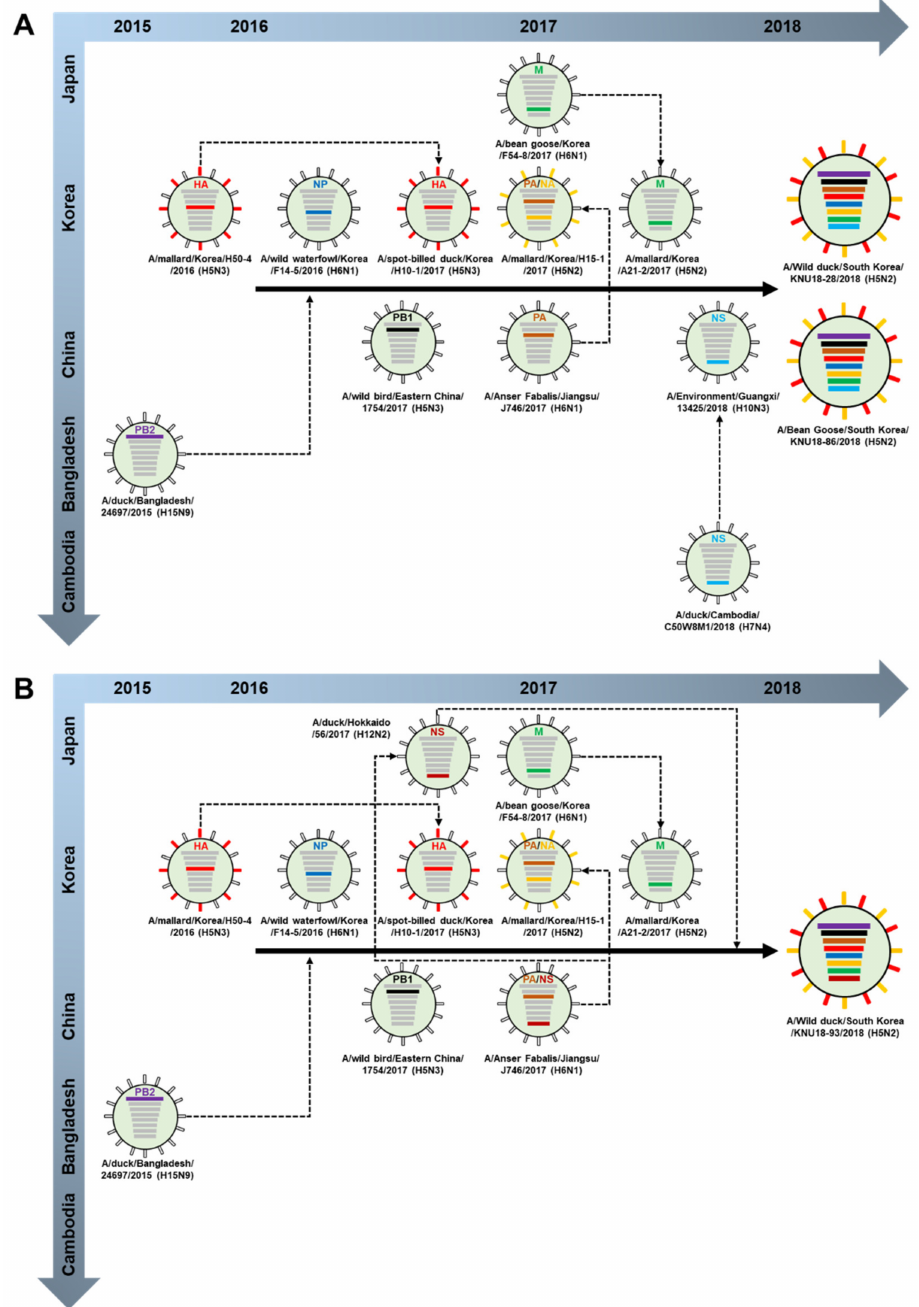
Figure 3. Hypothesis of the ancestor of each gene segment evolution of ( A ) KNU18-28 (A/Wild duck/South Korea/KNU18- 28/2018 (H5N2)), KNU18-86 (A/Bean Goose/South Korea/KNU18-86/2018 (H5N2)), and ( B ) KNU18-93 (A/Wild duck/South Korea/KNU18-93/2018 (H5N2))